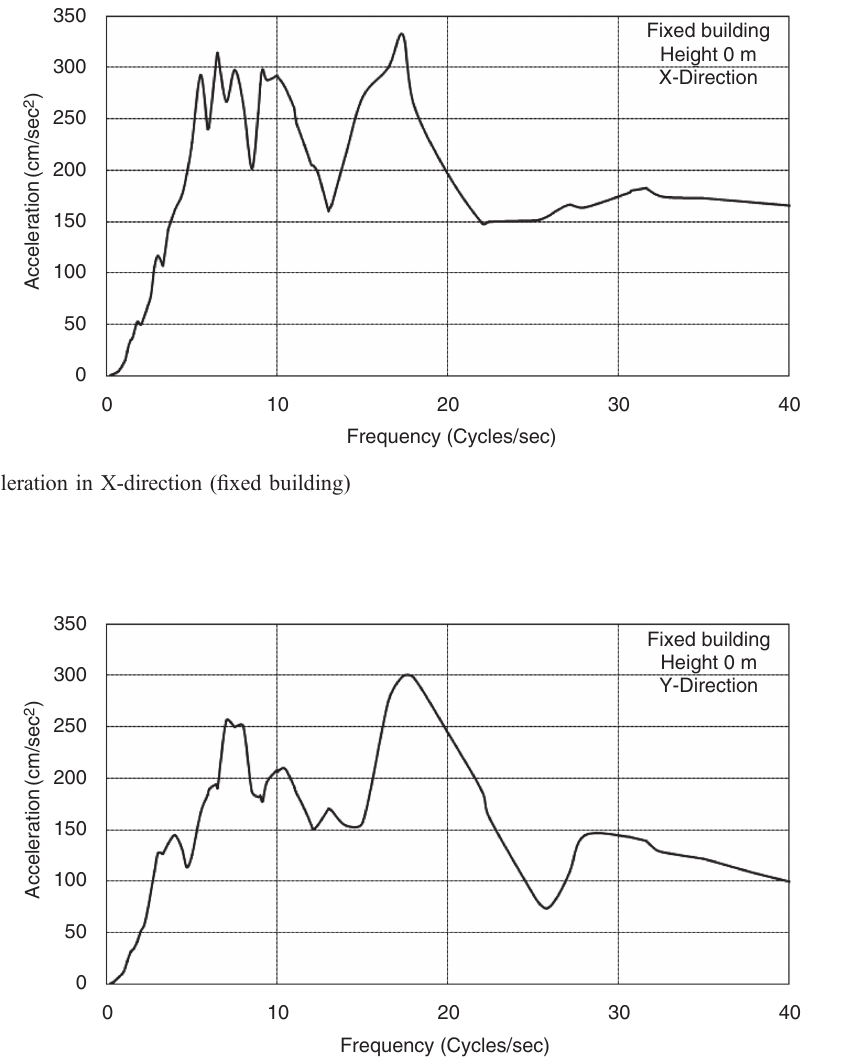
Fig. 9. Spectral Acceleration in Y-direction ( fi xed